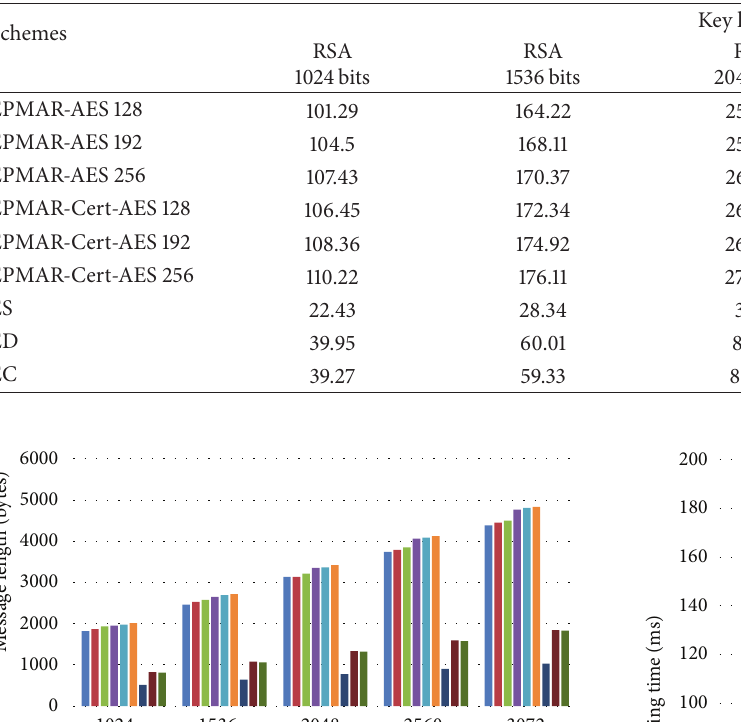
Table 9: Total computational time—online transaction (ms).